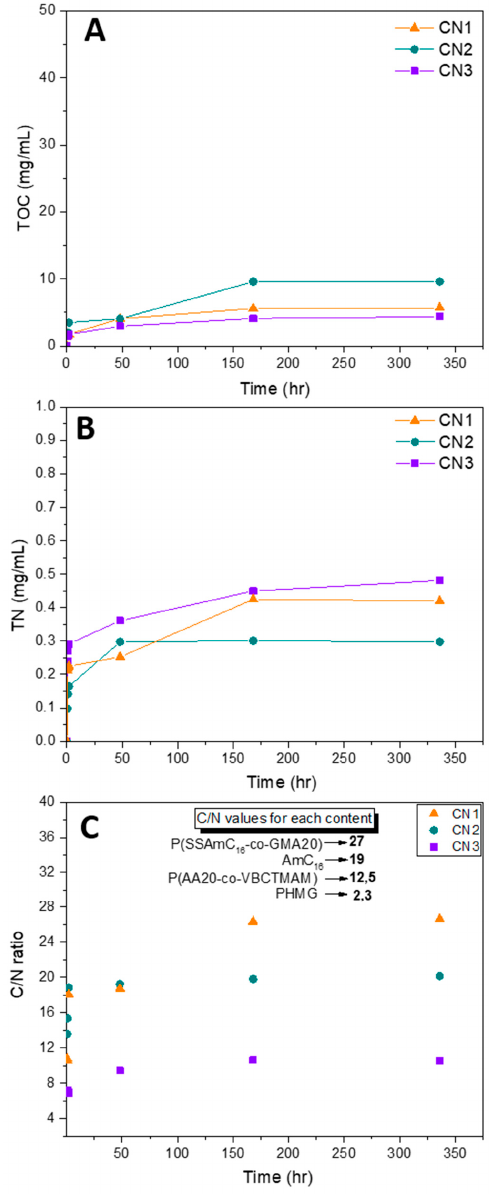
Figure 6. Measurements of ( A ) Total Organic Carbon (TOC), ( B ) Total Nitrogen (TN) and ( C ) atomic C/N ratio as a function of time after immersion of coated nets CN1, CN2 and CN3 in aqueous 0.6 M NaCl solution for 15 days (2nd cycle).